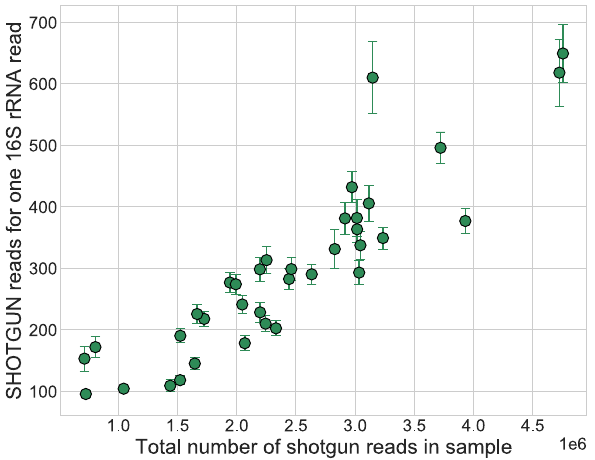
Figure 6. Intercepts of shotgun vs 16S abundance linear regressions of caeca samples against the total number of reads in each set, representing the number of shotgun sequences corresponding to one 16S sequence. Error bars correspond to the confidence interval for the parameter provided by the